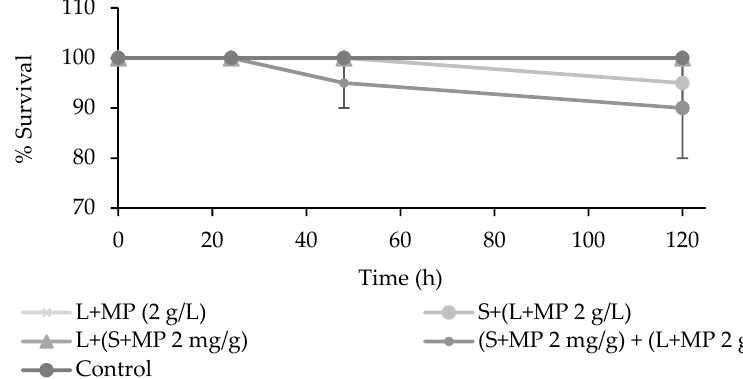
Figure 1. Tubifex tubifex mortality after exposure to microplastics (MPs) in media (L + MP (2 g/L)) only, in sediment and media with the media contaminated with MPs (S + (L + MP 2g/L), in sediment and media with the sediment contaminated (L + (S + MP 2 mg/g)), and sediment and media both contaminated with MPs ((S + MP 2 mg/g) + (L + MP 2 g/L)).